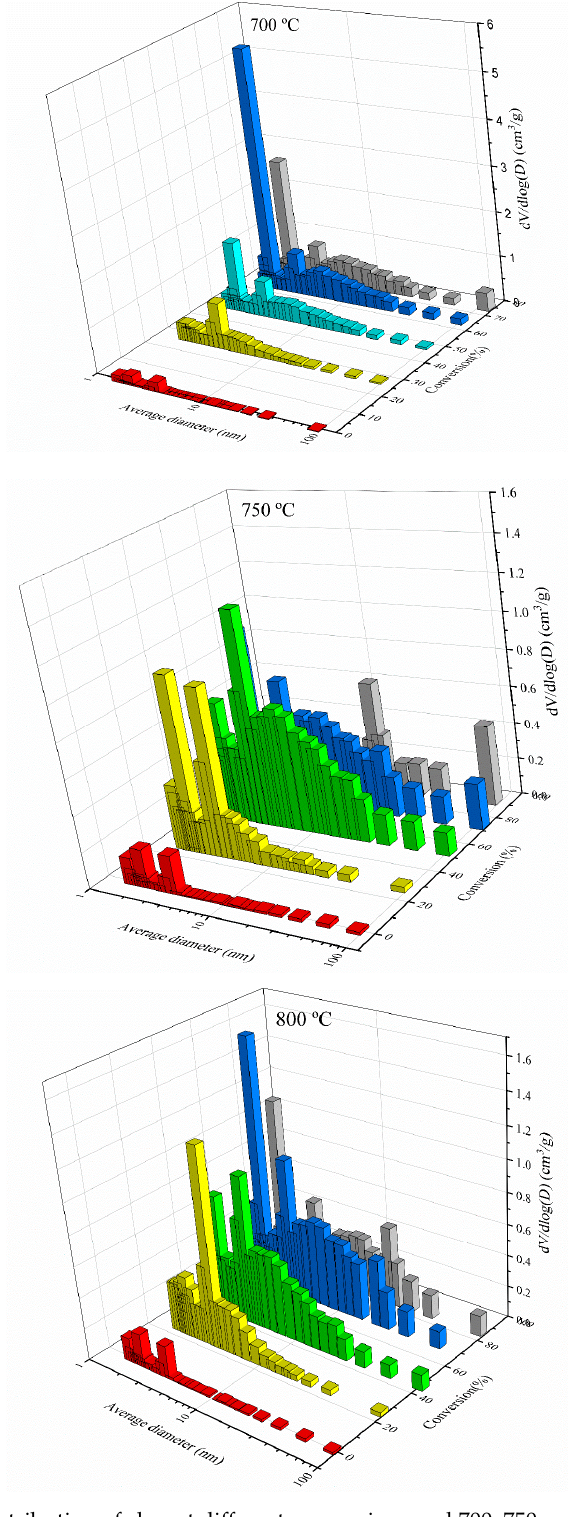
Figure 5. Pore size distribution of char at different conversions and 700, 750, and 800 °C according to Barrett–Joyner–Halenda (BJH) method.